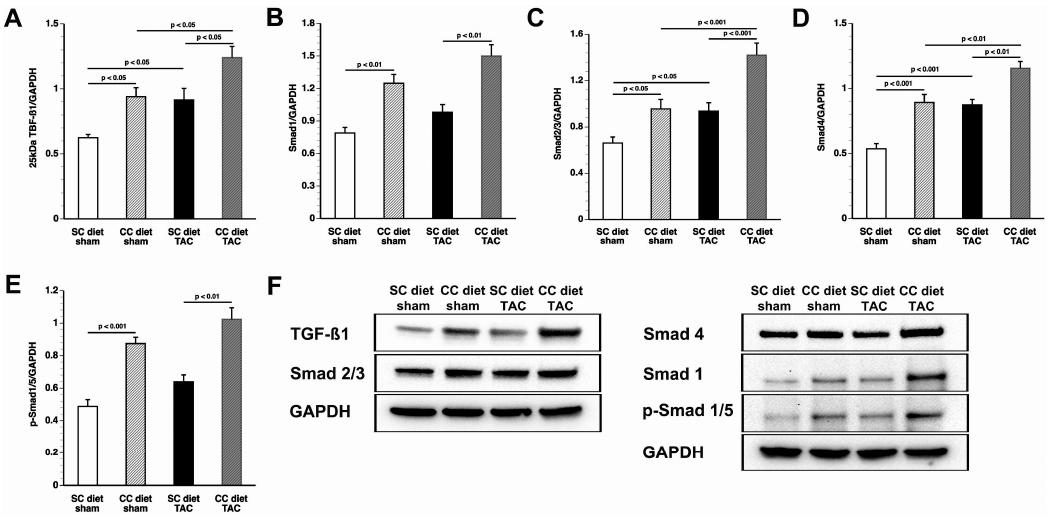
Figure 5. Quantification of TGF- β 1 and pro-fibrotic signaling molecules in the myocardium by Western blot. Intensities of immunoreactive bands on Western blots were quantified by densitometric analysis. Bar graphs illustrating the 25-kD isoform of: TGF- β 1 ( A ); Smad1 ( B ); Smad2/3 ( C ); Smad 4 ( D ); and p-Smad1/5 ( E ) protein levels quantified by Western blot in the myocardium of SC diet sham ( n = 10), CC diet sham ( n = 10), SC diet TAC ( n = 10), and CC diet TAC ( n = 10) mice eight weeks after intervention. All protein levels were normalized to the glyceraldehyde-3-phosphate dehydrogenase (GAPDH) protein level. Representative images of Western blots are shown in panel ( F ).